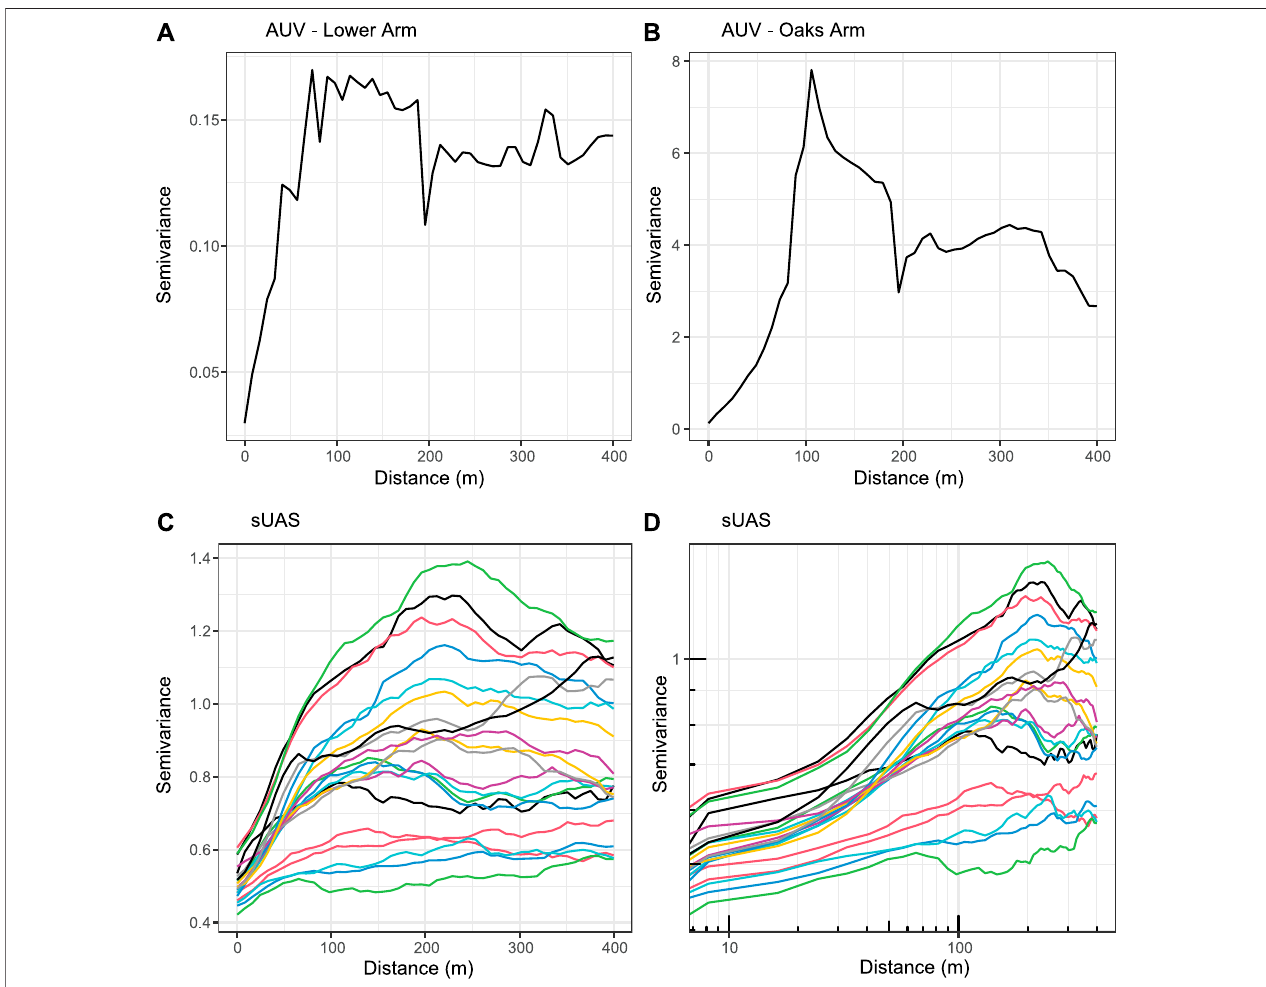
FIGURE9| Semivariograms ofchlorophyll- a measurements from (A) AUVMissionsinLowerArm (B) AUVMissioninOaksArm;and (C) linesextracted fromsUAS data in Lower Arm. Panel (D) shows the log-log scale of the sUAS semivariograms shown in panel (C) , which is used for determining the CSV. Semivariograms demonstrate spatial autocorrelation with close data points having less variation. The semivariograms level off at the CSV at roughly 70 – 100 m for the AUV data and at 175 m on average for the sUAS data, with values ranging from 70 to 300 m for the 21 lines evaluated.